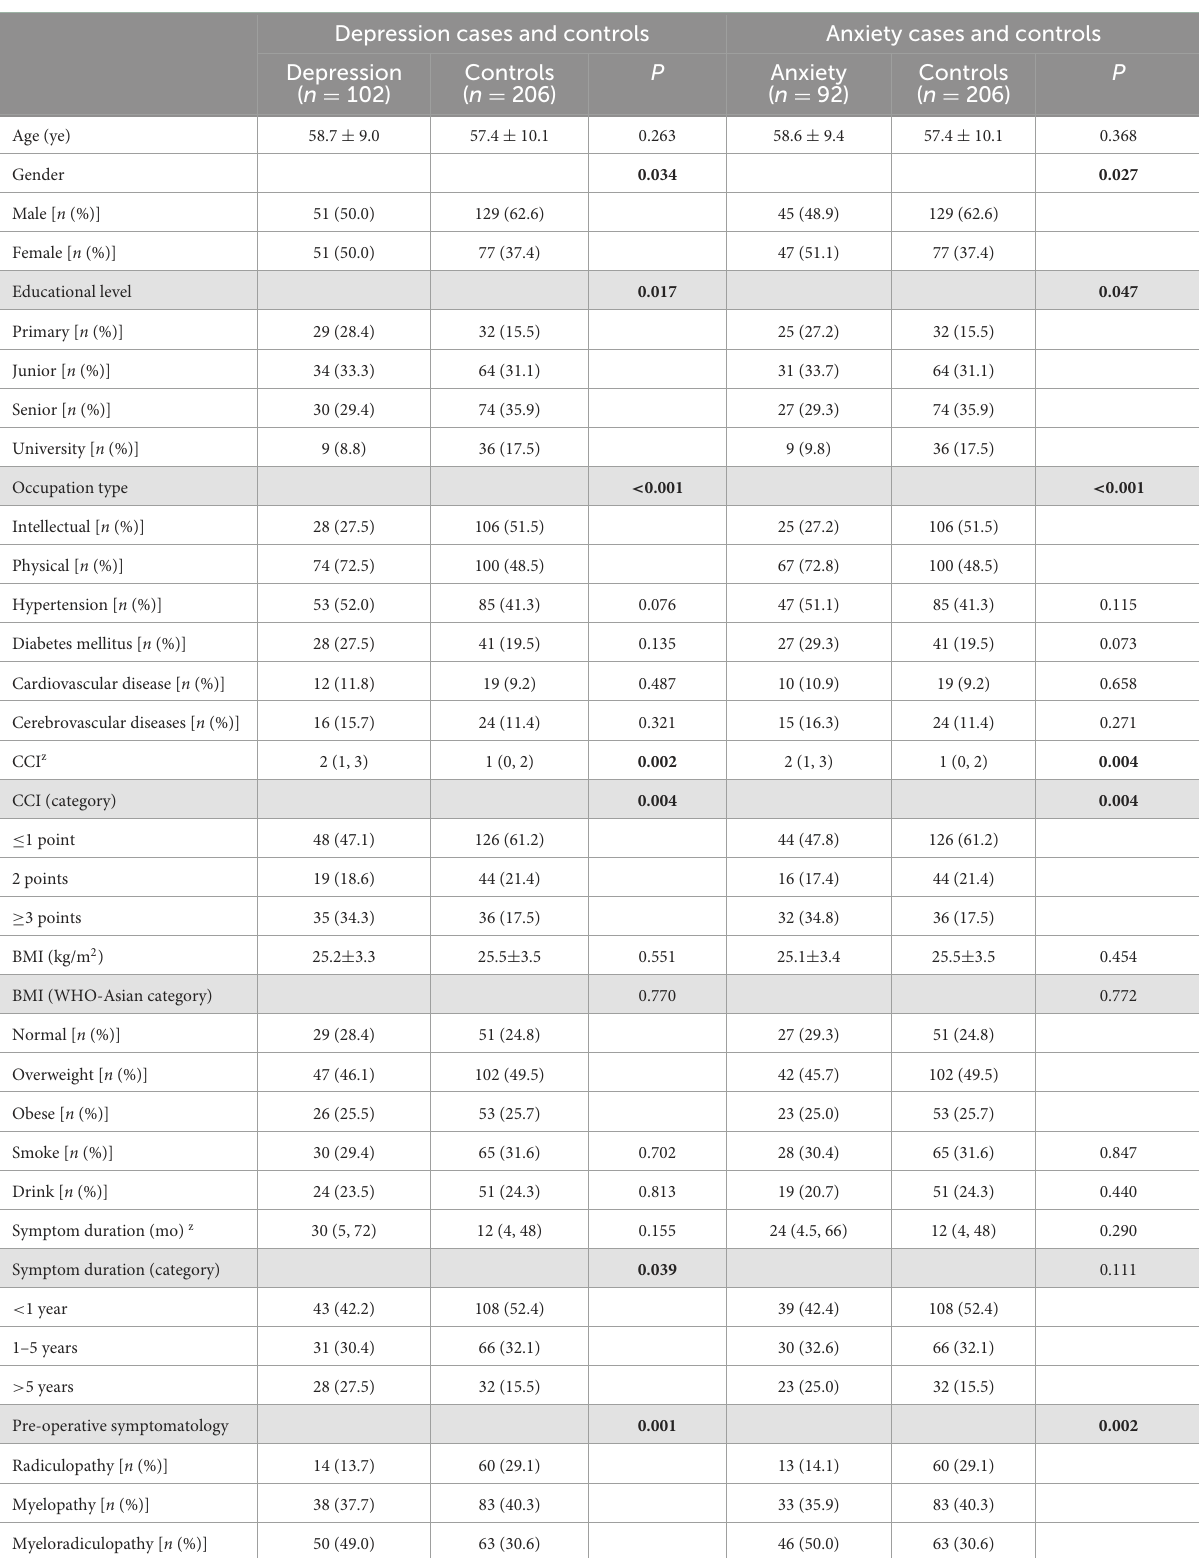
TABLE 1 Description and comparison of patient demographic and clinical characteristics. Depression cases and controls Anxiety cases and